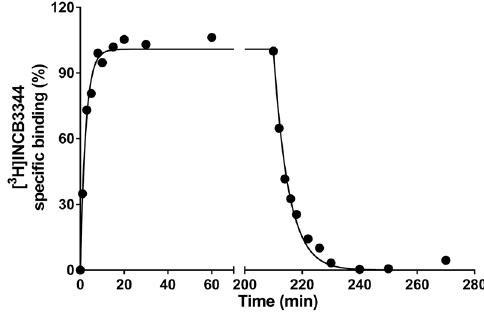
Figure 2. Kinetic characterization of [ 3 H]INCB3344 in murine CCR2. Association and dissociation